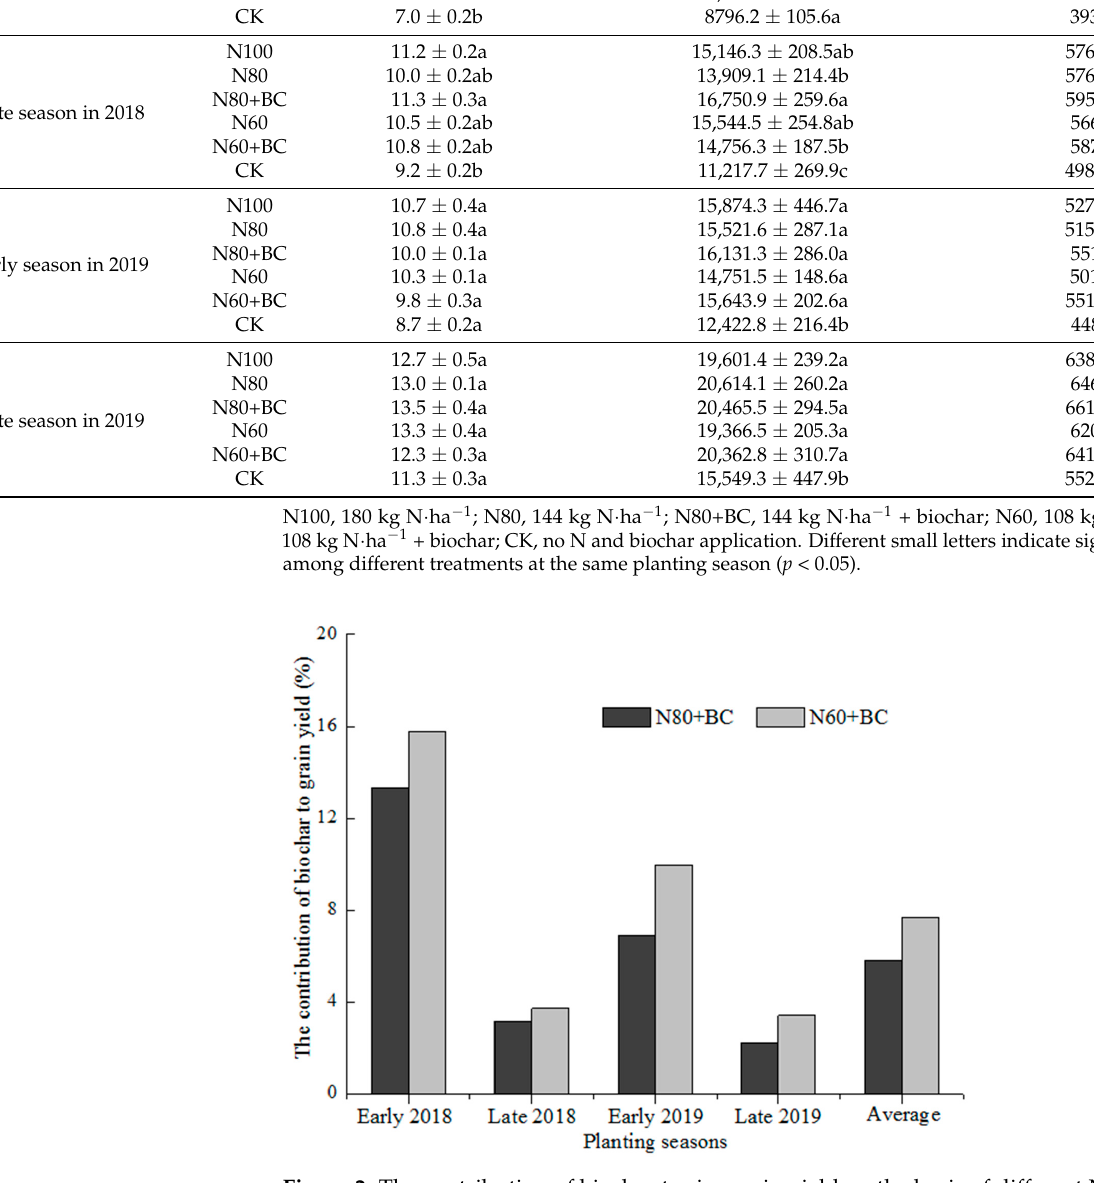
Figure 2. The contribution of biochar to rice grain yield on the basis of different N fertilizer levels. “The contribution” was calculated as the average grain yield of three repeated plots under treatments with or without biochar. N80+BC, 144 kg N·ha − 1 + biochar; N60+BC, 108 kg N·ha − 1 + biochar. “Average” refers to the average of the four